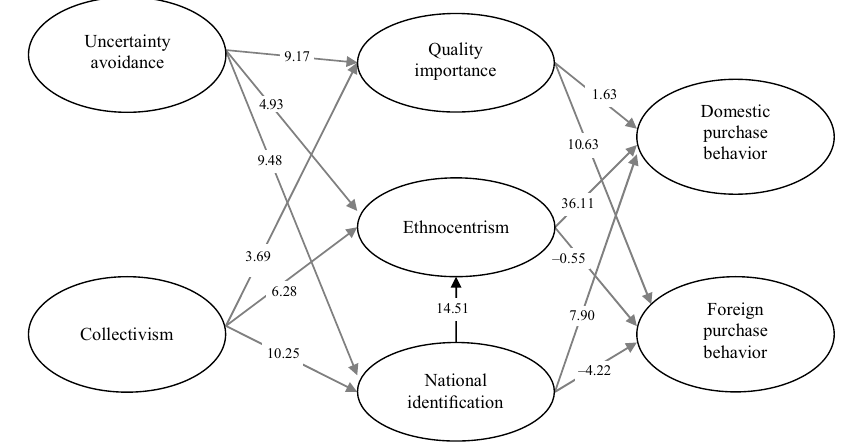
Fig. 2. Pooled model results –